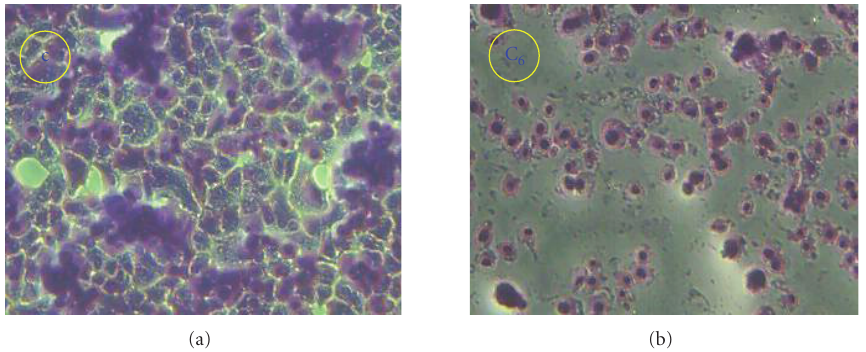
Figure 10: Tissue culture sections of Hep-2 cell line before (c) and after treatment with IrL I (C 6